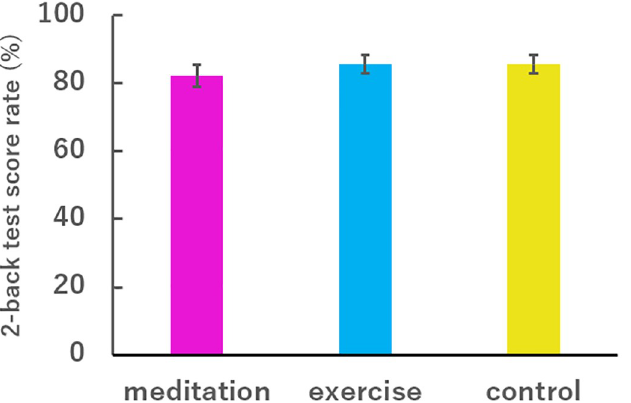
Fig 3. Scores (correct answer rate) in the 2-back tests. All participants performed the 2-back tests after meditation (red), exercise (blue), and control (yellow) tasks. The scores are shown as mean ± SEM. There is no significant